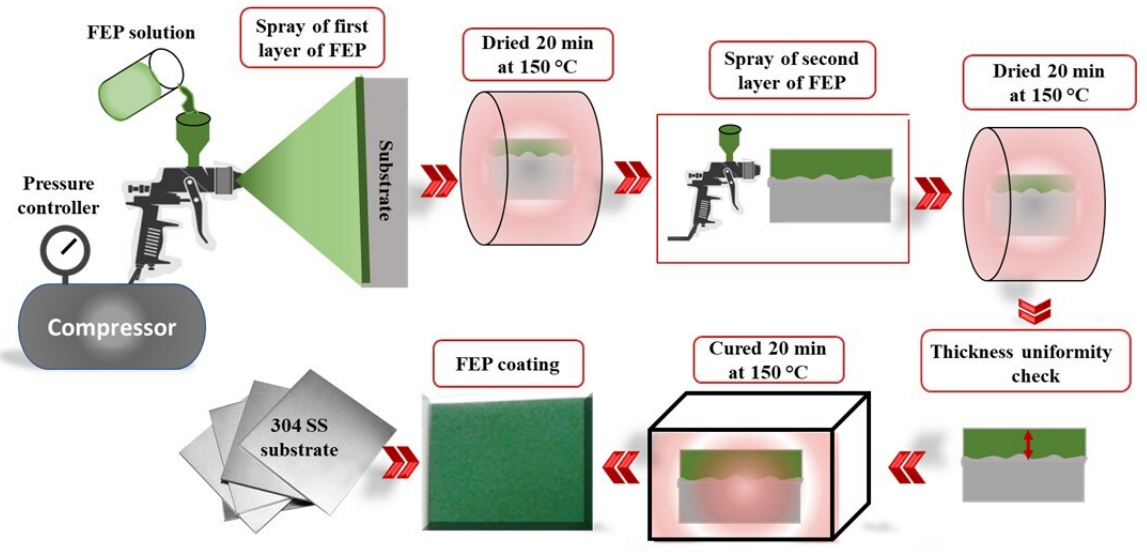
Figure 1. Processing cycle of FEP spraying on stainless steel.